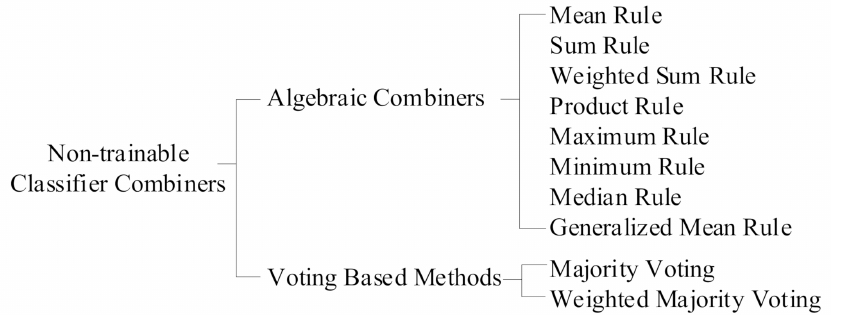
Figure 6. A list of non-trainable classifier